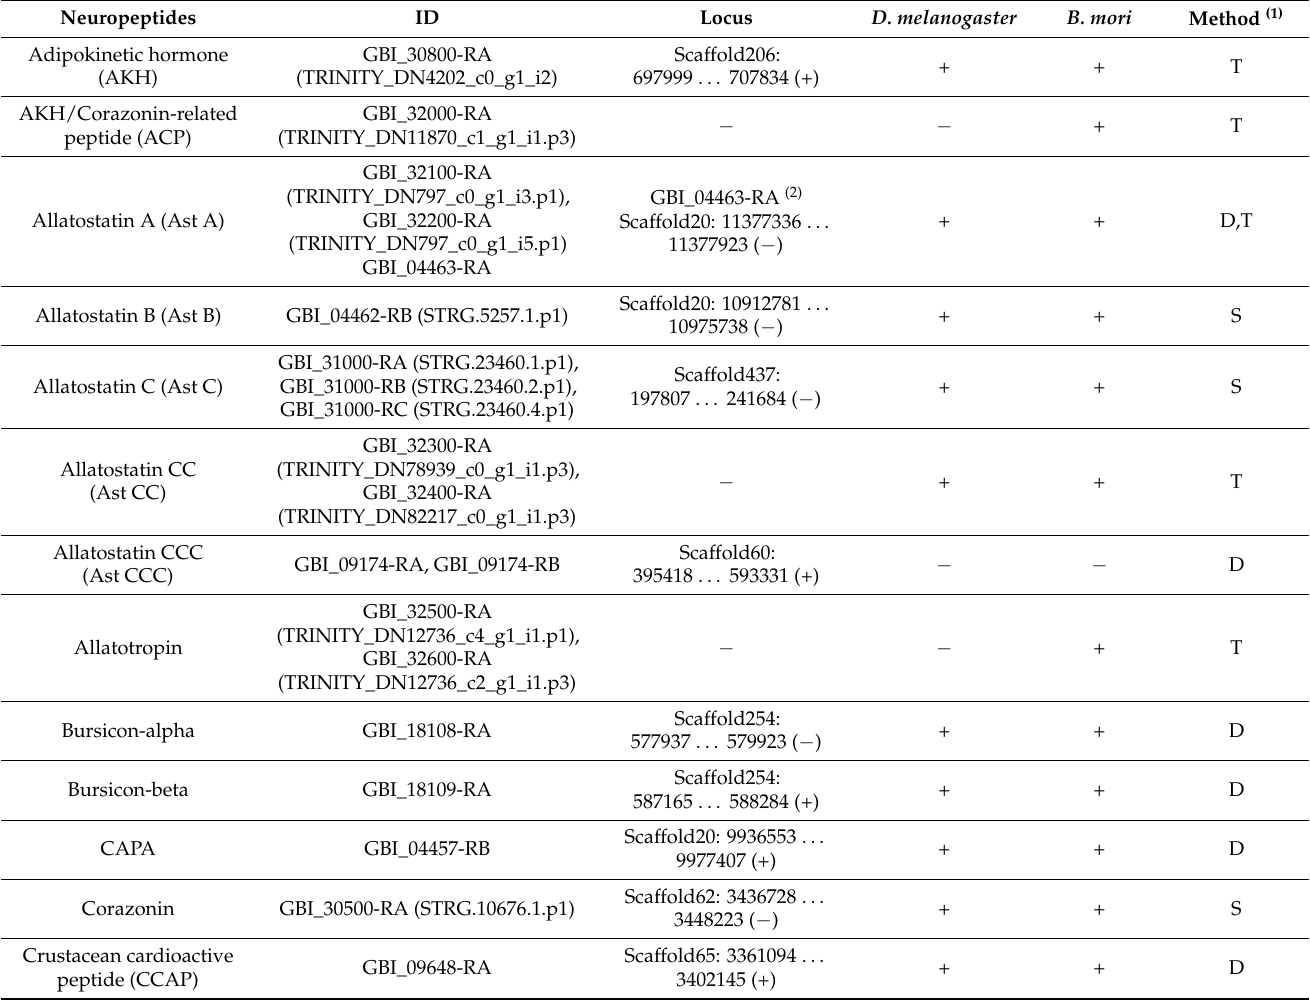
Table 1. Gryllus bimaculatus